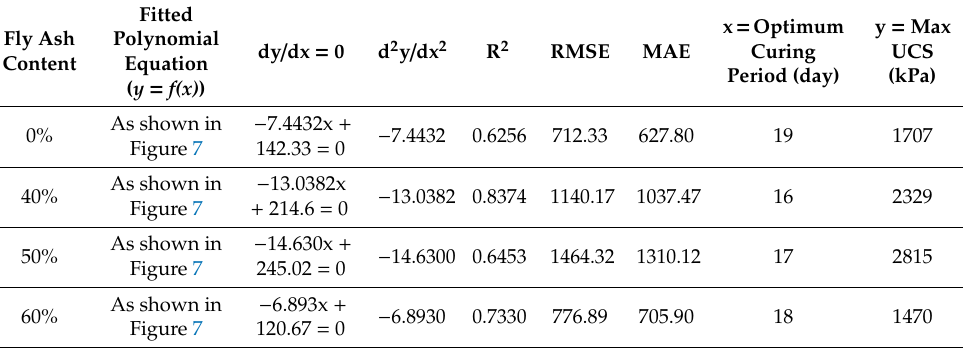
Table 3. Estimated optimum curing period and maximum UCS from the trend lines .